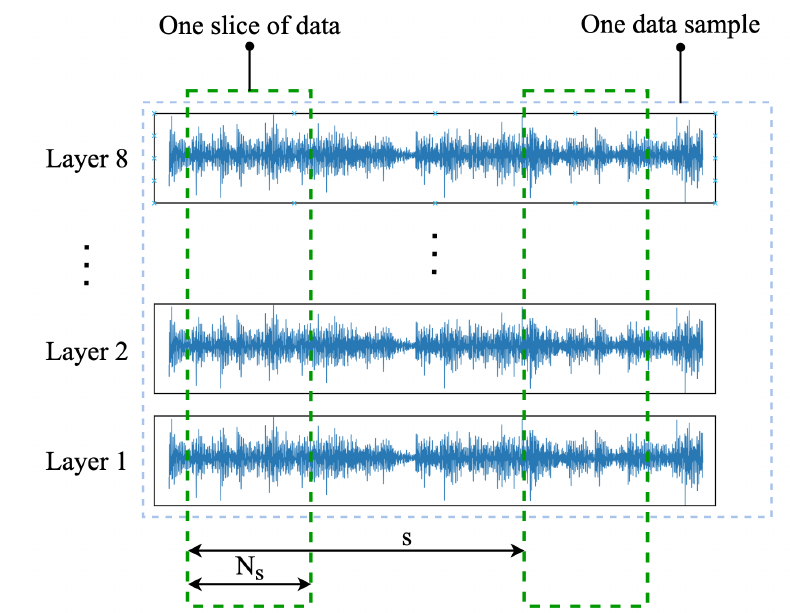
Figure 5. The illustration of data